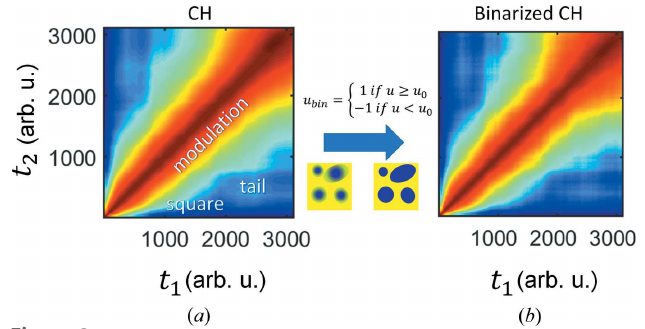
Figure 2 The result of the CH simulation is presented in ( a ) and represents similar features to the experiment (marked with text). ( b ) The TTC of the CH simulation with the binary modification of the 2D concentration field. Jet color bars of TTCs correspond to G ( q , t 1 , t 2 ) values. Above the blue arrow there is an equation used for binary modification and below there are schemes of the real-space 2D concentration field u ( r , t ) before and after binary modification. Parula color bars of the schemes correspond to the concentration distribution [from blue ( (cid:3) 1) to yellow (1) color]. The time of CH simulations is in arbitrary units (arb. u.). The presented range of time in arb. u. of the CH simulation corresponds to the experimental time (see Fig.